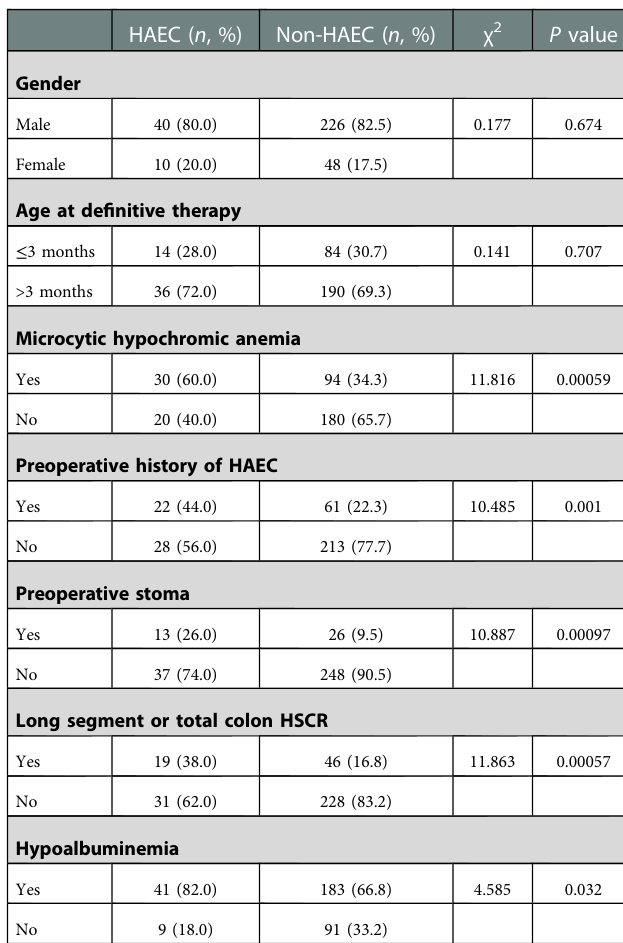
TABLE 3 Analysis of postoperative HAEC in children with HSCR.